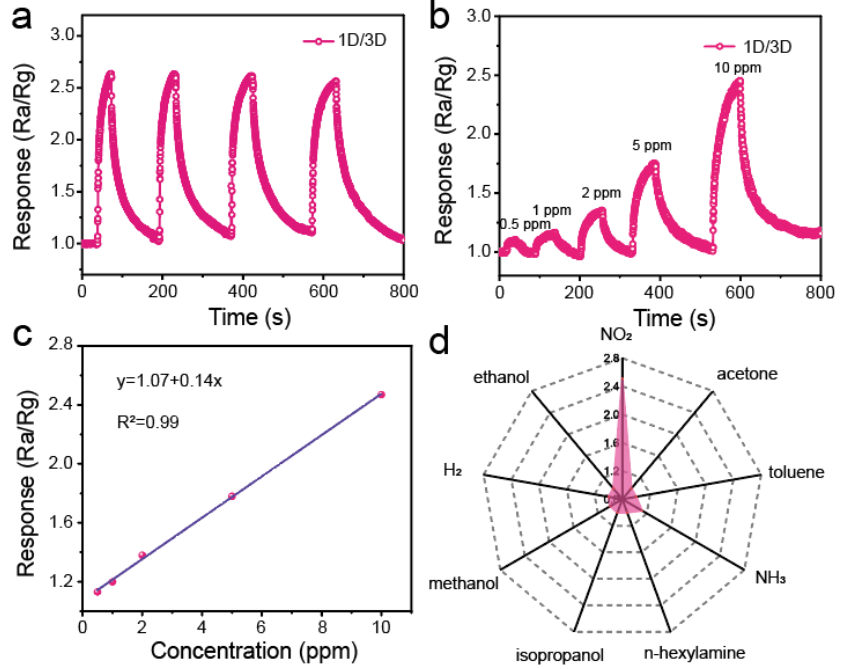
Figure 4. NO 2 -sensing performances of the 1D/3D hybrid-structured PyPbI 3 /FACs perovskite-based sensor: ( a ) reversibility toward 10 ppm NO 2 , ( b ) the transient response toward different concentrations of NO 2 , ( c ) curve of response versus NO 2 concentrations and ( d ) selectivity to various gases with 10 ppm.